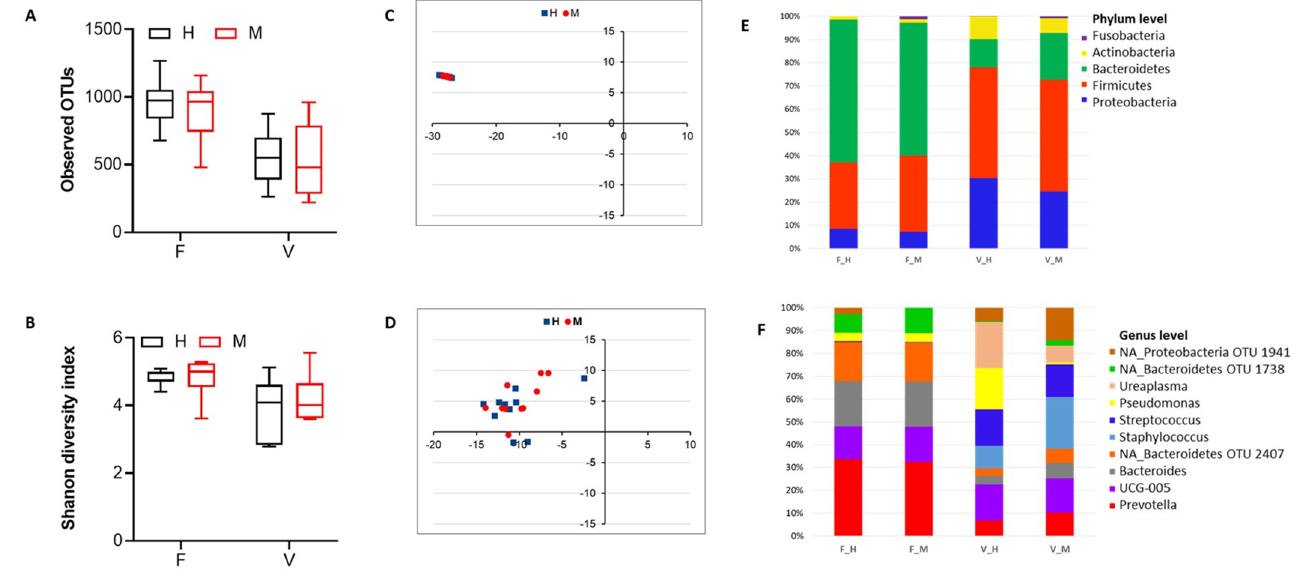
Figure 2. Comparison of microbial diversity and taxonomic composition between fecal (F) and vaginal (V) microbiomes found in metritis (M) and healthy (H) animals prepartum. Box plots showing microbial community species richness and alpha diversity based on observed OTUs ( A ) and Shannon diversity index ( B ), respectively. NMDS plots based on Bray-Curtis dissimilarity distances between pre-calving fecal ( C ) and vaginal ( D ) microbiomes of M and H cows. Individual points represent single cows ( n = 10 for each group). Blue—H cows; Red—M cows. Bar graphs showing averaged relative abundances and distribution for the top 5 phyla ( E ) and top 10 genera ( F ). Unclassified genera are denoted by NA. Relative abundances were rescaled to account for only the 5 (phyla) and 10 (genera) most abundant phyla. Taxonomic profiles for the top 50 taxa are provided in Supplementary Table S1. F—fecal; V—vaginal; F_H—fecal healthy, F_M—fecal metritis, V_H—vaginal healthy, V_M—vaginal metritis.